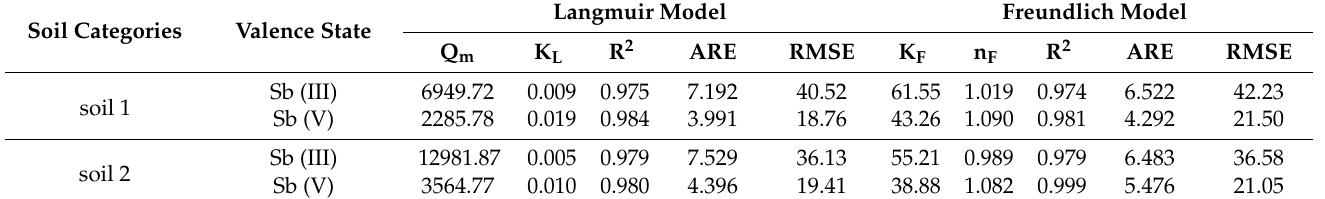
Table 3. Sb (III) and Sb (V) isothermal adsorption fitting parameters.